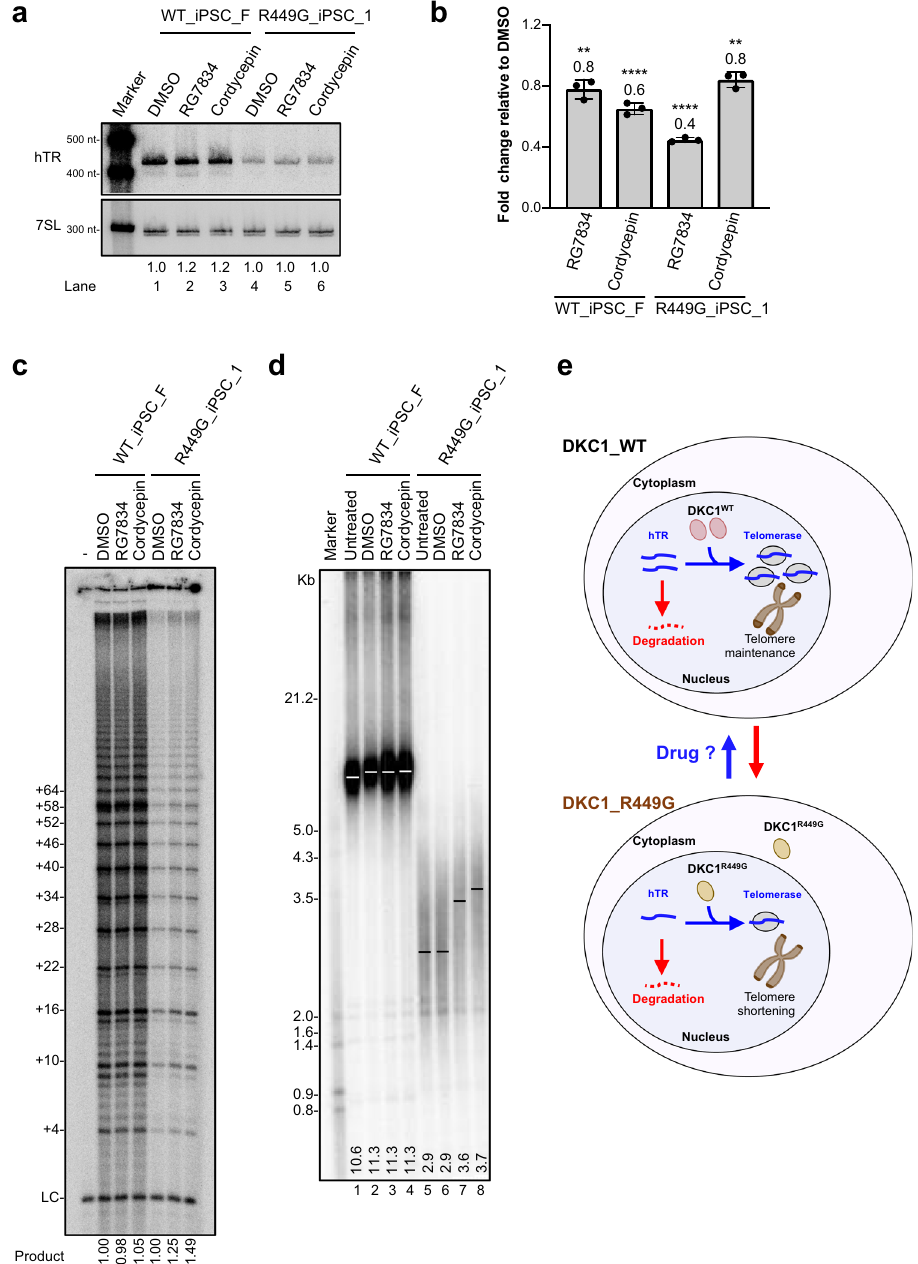
Fig. 6 Inhibition of oligoadenylation of hTR restores telomerase activity and telomere length in DKC1 mutant iPSCs. a Northern blot analysis of hTR from WT_iPSC_F, R449G_iPSC_1 and R449G_iPSC_2 cells treated with RG7834, Cordycepin, or DMSO. A probe against 7SL RNA served as a loading control. b Total RNA prepared from WT_iPSC_F and R449G_iPSC_1 cells treated with RG7834, Cordycepin, or DMSO was subjected to qRT – PCR for oligoadenylated hTR. Bar graph of the mean fold change relative to DMSO-treated samples and normalized to GAPDH, ATP5b, and HPRT. Mean values were calculated from triplicate qRT – PCR experiments with three biological replicates, with bars representing standard error of the mean (s.e.m.). c Direct telomerase activity assay of cell lysates from WT_iPSC_F and R449G_iPSC_1 cells treated with RG7834 or cordycepin. 18-nucleotide telomeric primers (TTAGGG)3 were used. A 32 P end-labeled 18-nucleotide telomeric primers (TTAGGG)3 was added as loading control (LC). The numbers on the left ( + 4, + 10, + 16, + 22, + 28, etc.) indicate the number of nucleotides added to the telomeric-primer for each major band seen. d Telomere lengths determined by TRF analysis of gDNA prepared from WT_iPSC_F and R449G_iPSC_1 treated with RG7834, Cordycepin, or DMSO. e Schematic illustrating the dysfunction of DKC1_R449G in telomere